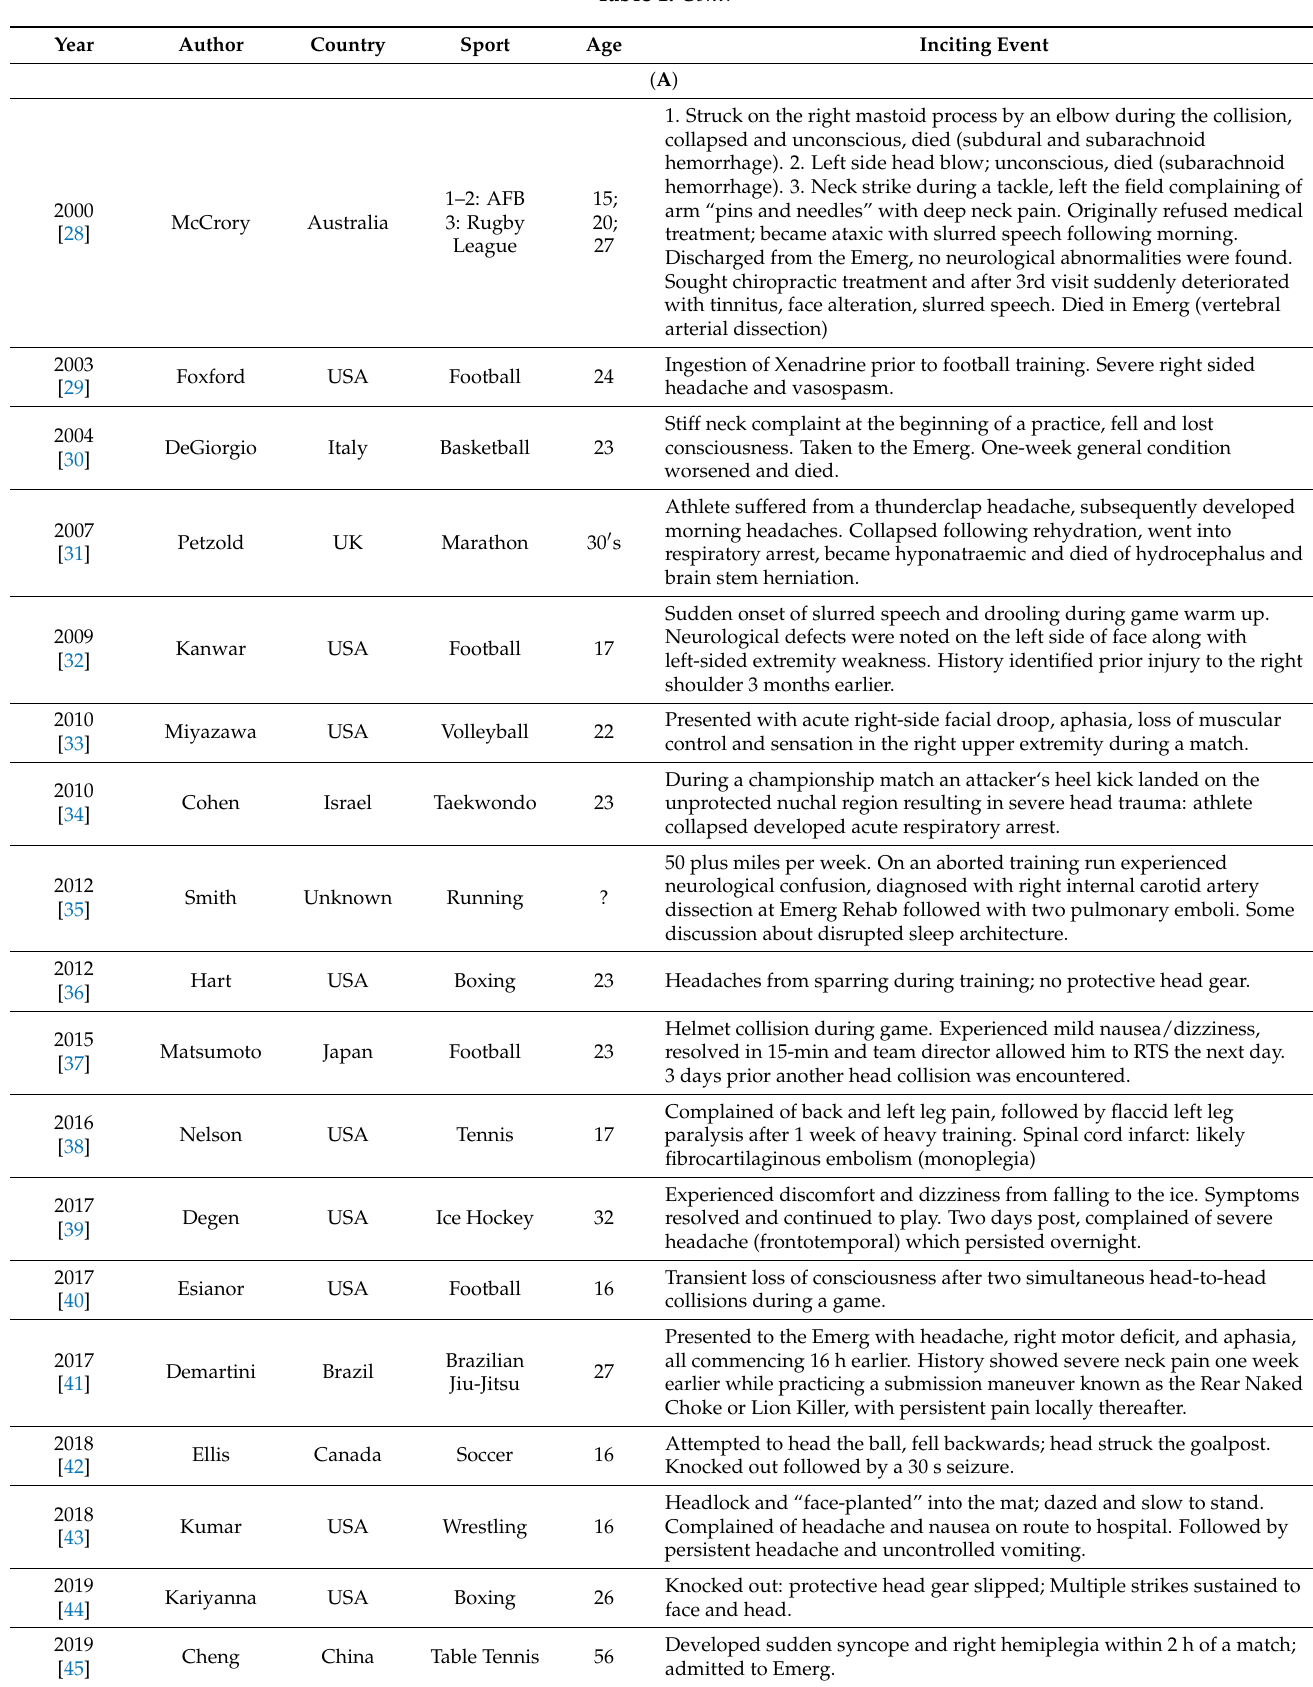
1. Struck on the right mastoid process by an elbow during the collision, collapsed and unconscious, died (subdural and subarachnoid hemorrhage). 2. Left side head blow; unconscious, died (subarachnoid hemorrhage). 3. Neck strike during a tackle, left the field complaining of arm “pins and needles” with deep neck pain. Originally refused medical treatment; became ataxic with slurred speech following morning. Discharged from the Emerg, no neurological abnormalities were found. Sought chiropractic treatment and after 3rd visit suddenly deteriorated with tinnitus, face alteration, slurred speech. Died in Emerg (vertebral arterial dissection) Ingestion of Xenadrine prior to football training. Severe right sided Football 24 headache and vasospasm. Stiff neck complaint at the beginning of a practice, fell and lost 23 consciousness. Taken to the Emerg. One-week general condition worsened and died.